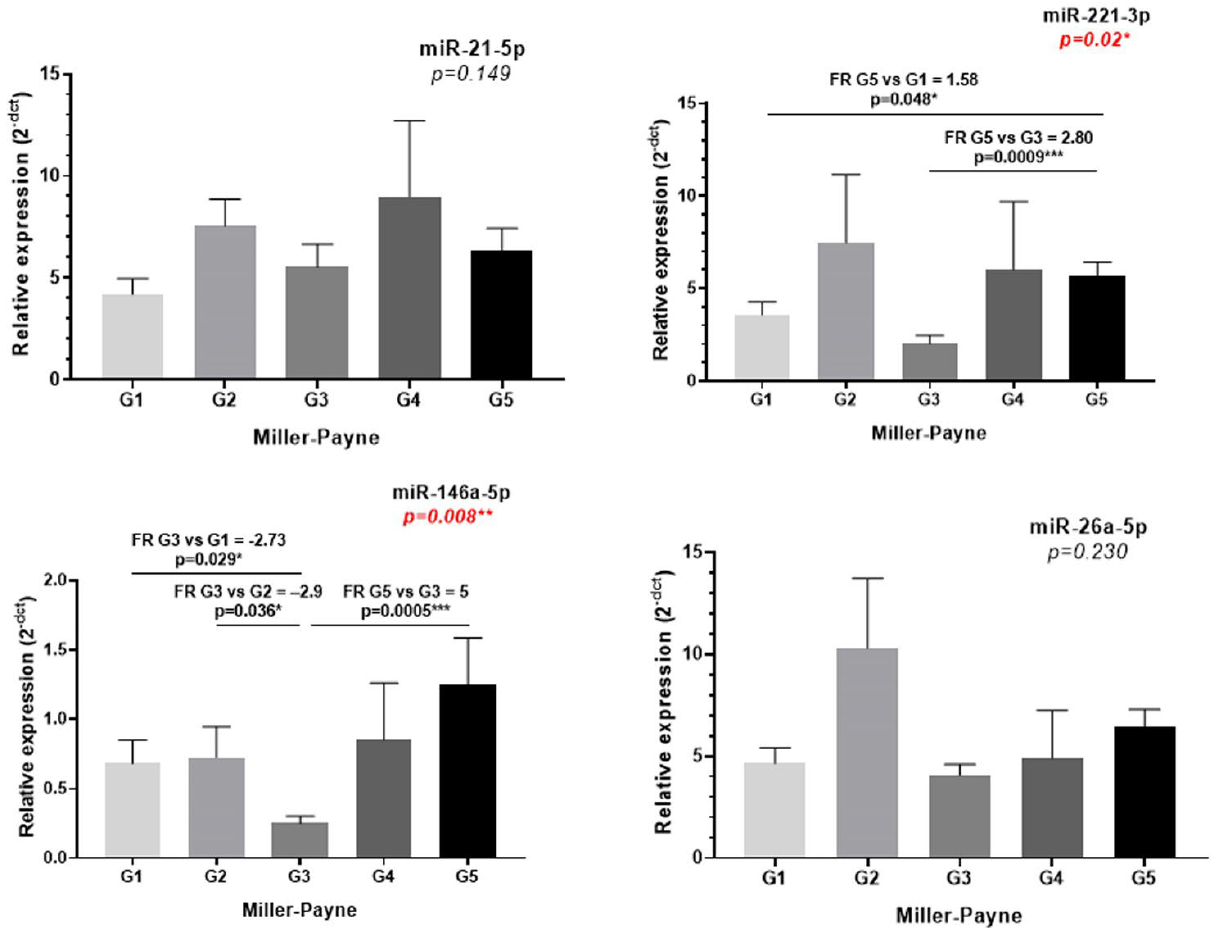
Figure 2. The miR-21-5p, 221-3p, 146a-5p and 26a-5p expression in tissue samples, according to MP staging. The differences between groups were evaluated with Kruskal–Wallis test, and pairwise comparisons were performed with Dunn’s test (* p < 0.05, ** p < 0.01, *** p < 0.001).